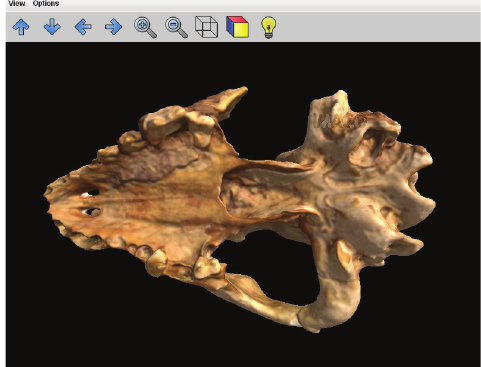
Fig. 2. Visualization of a Protocyon fossil. The Protocyon is an animal that inhabited caves in Brazil during the Pleistocene (period between 1.816.000 and 11.500 years ago). This fossil is property of the UFPR Natural Science Museum.